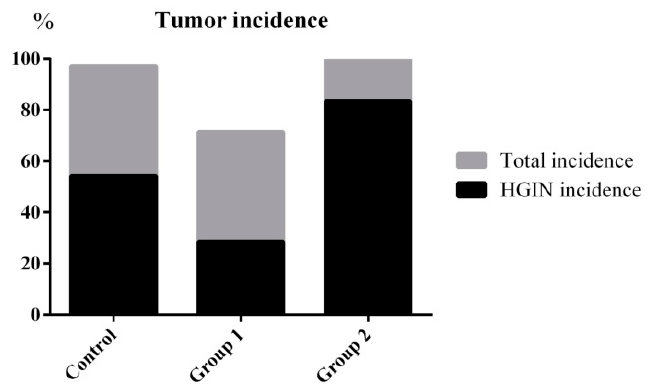
Figure 3. Tumor incidence and HGIN incidence statistical results. ASR extract administration in the initial stage (Group 1) reduced the tumor incidence and HGIN incidence compared with the control group. ASR extract administration in the promotion stage (Group 2) increased the HGIN incidence without inhibiting the tumor incidence.